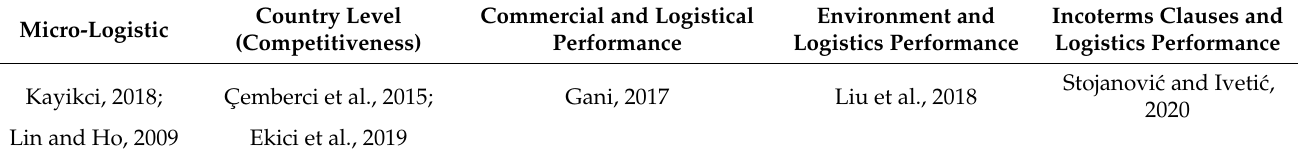
Table 1. Referral studies